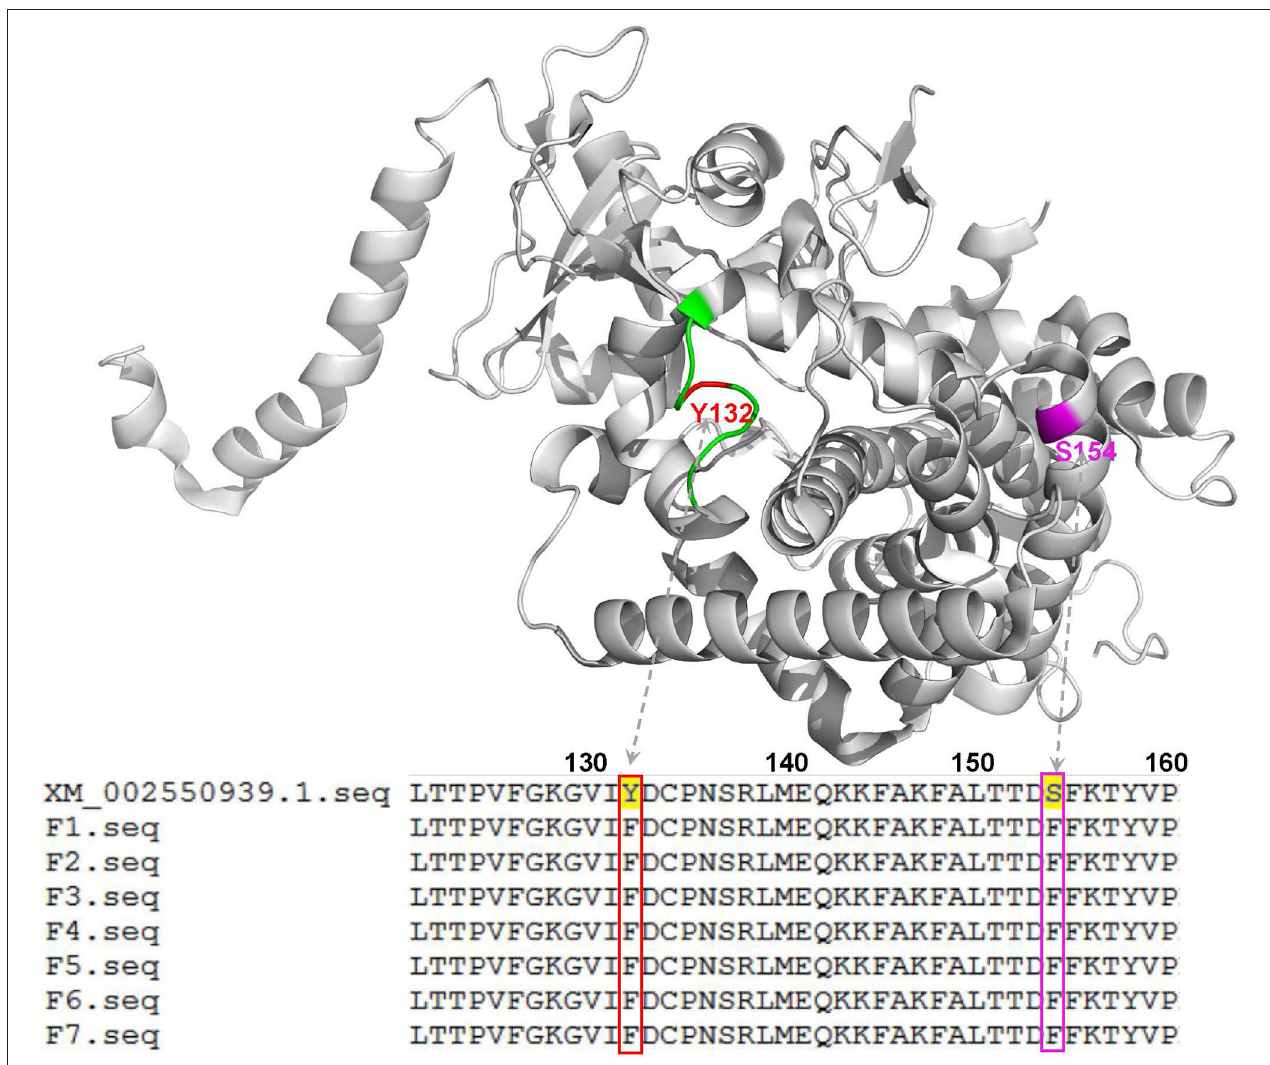
FIGURE 2 | Three-dimensional model of the ERG11 enzyme of C. tropicalis using 5JLC (http://www.pdb.org) as the template to analyze the indicated gene sequences with mutations in this study. Green, the BC loop; red, the mutation site of Y132F; magenta, the mutation site of S154F. XM_002550939.1, the indicated gene sequence provided by GenBank; F1-F7, the 7 isolates of C. tropicalis with azole